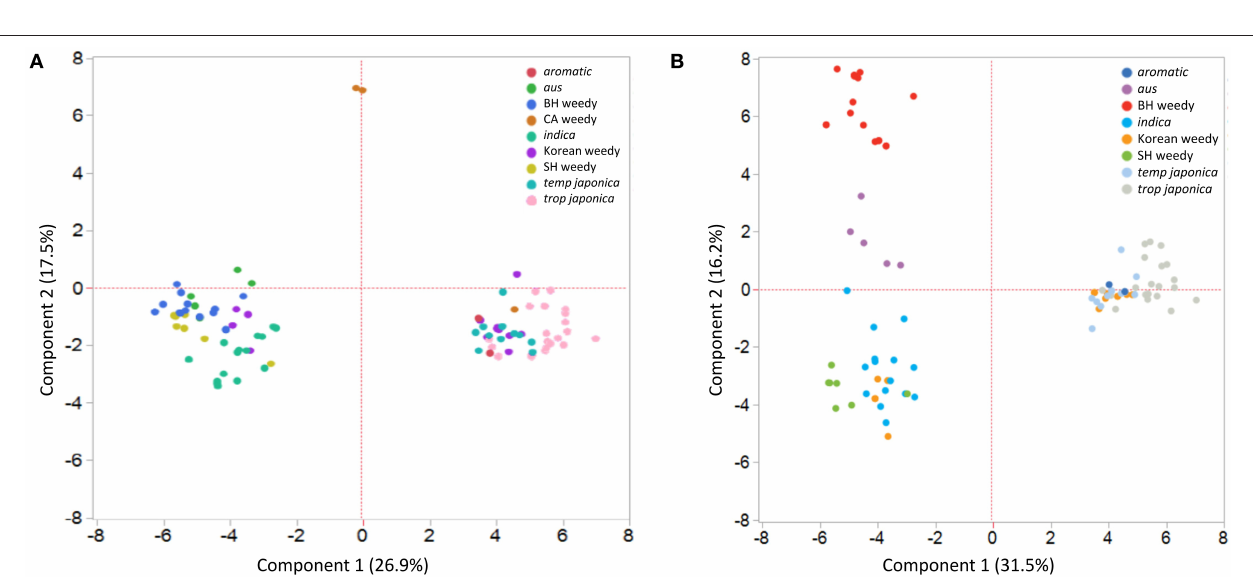
FIGURE 2 | Principal Component Analysis (PCA) of cultivated and weedy rice including California weedy rice (A) and without California weedy rice. (B) Korean weedy rice groups with temperate japonica cultivars and indica cultivars.